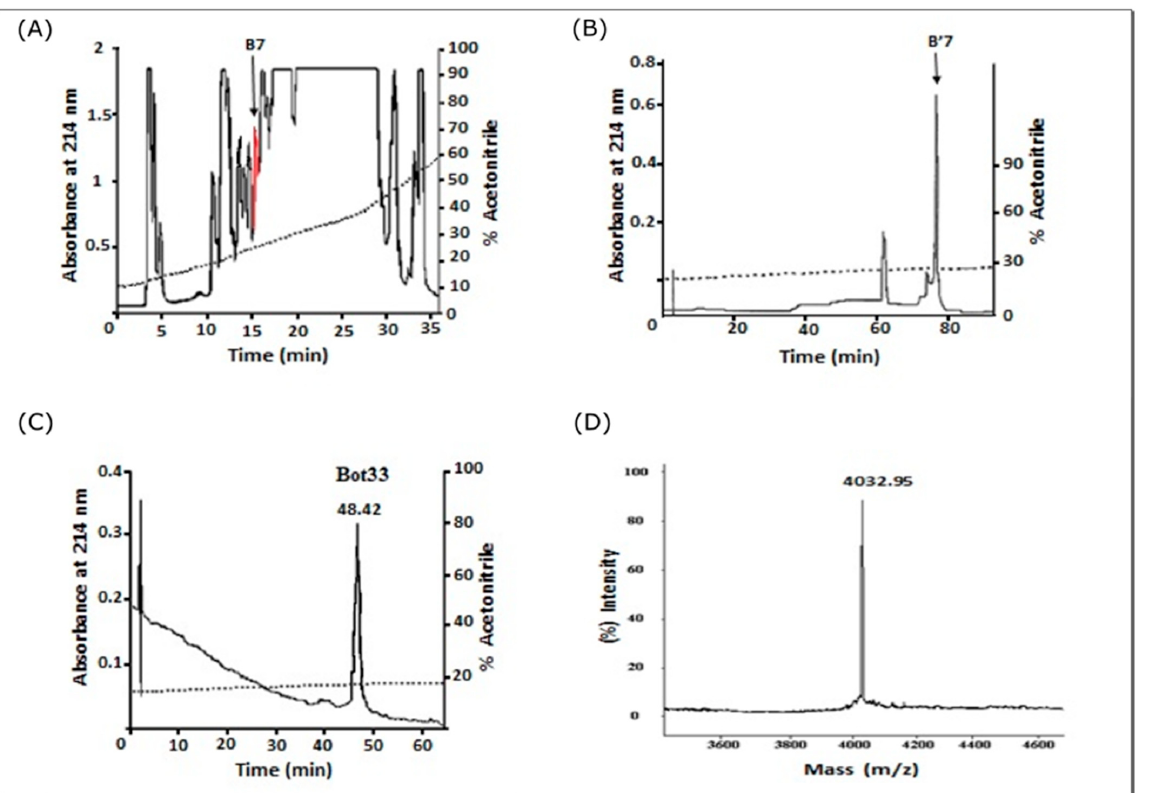
Figure 1. Purification of Bot33 from Buthus occitanus tunetanus scorpion venom. ( A ) Chromatography of fraction BotG50 on C18-RP-HPLC column. ( B ) Chromatography of fractionB7 ′ on C18-RP-HPLC, B’7 was collected. ( C ) Bot33 purified from the fraction B’7 on C18-RP-HPLC. It is collected at 48.04 min. ( D ) Mass spectrometry of native Bot33 using MALDI-TOF.